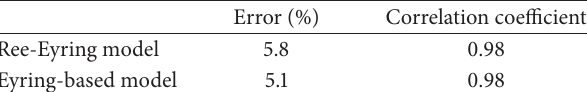
Table 3: Average error and correlation